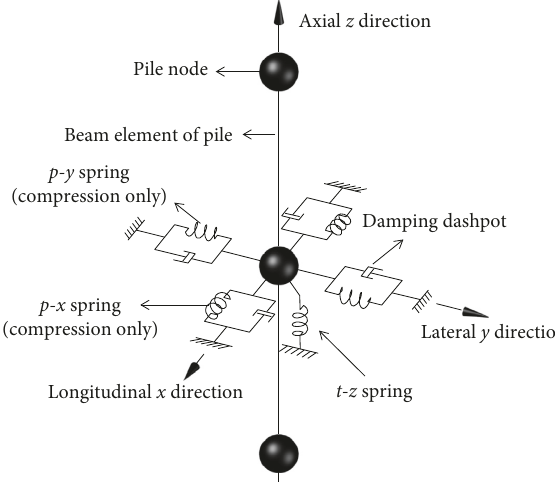
Figure 3: Schematic of SPI